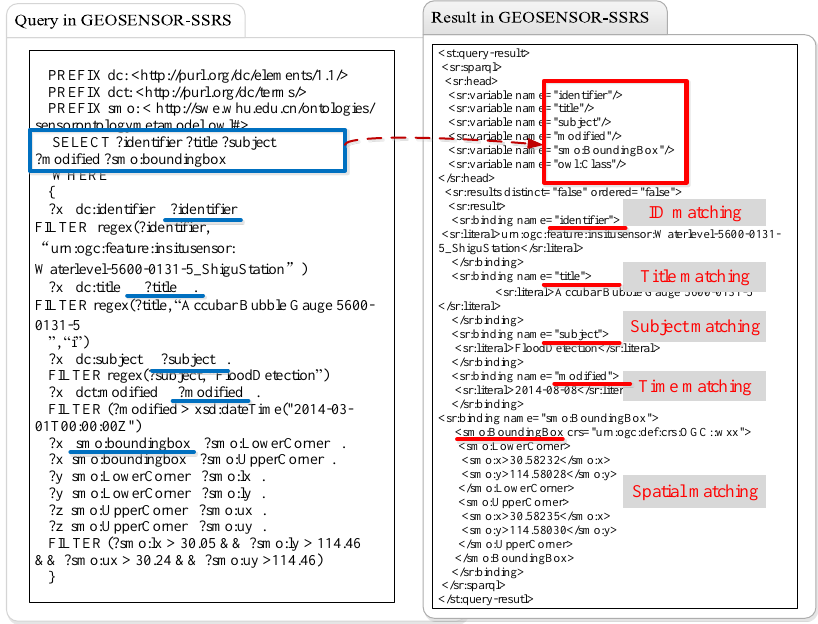
Figure 6. The request and response of a SPARQL Query.